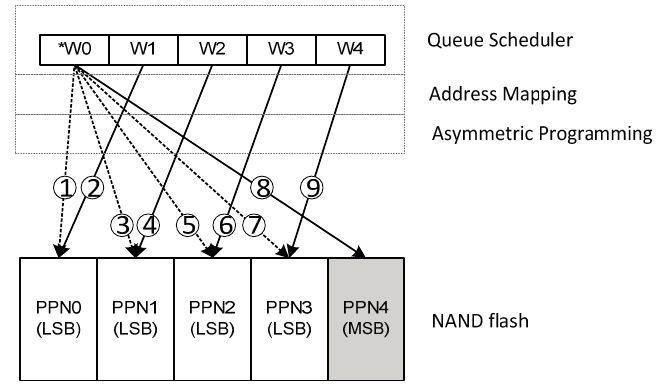
Figure 7. An example of the request feedback